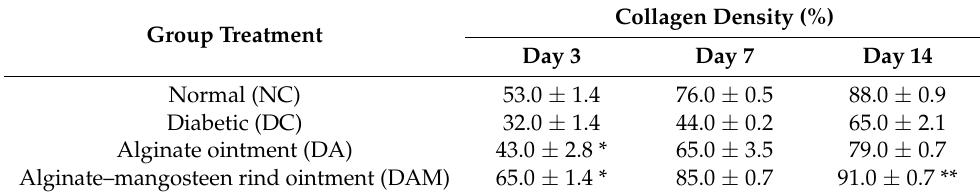
Table 8. Cell counts considering the mean and standard deviation of collagen